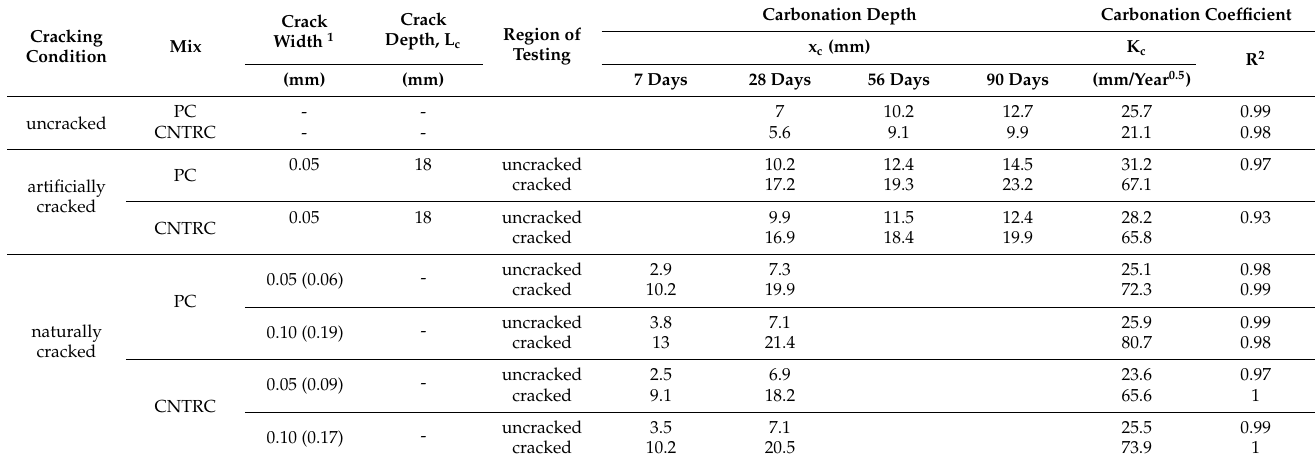
Table 6. Carbonation resistance for concrete under different cracking